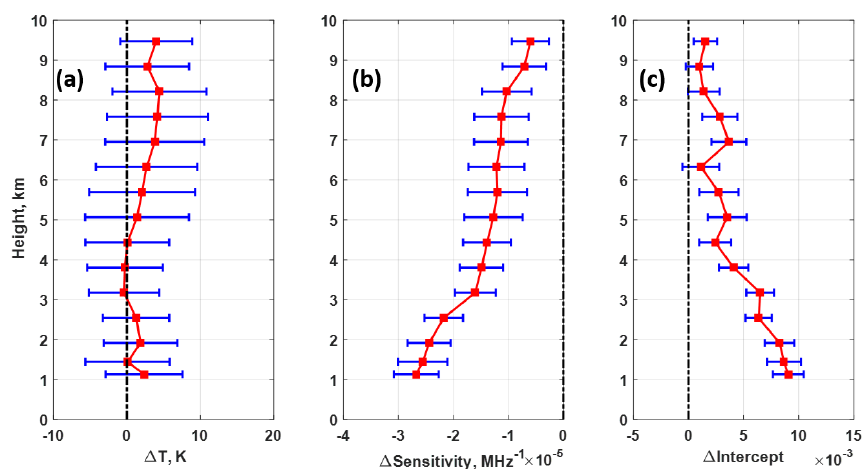
Figure 11. (a) Difference in temperature between dropsondes used in SRRC and the one during A2D instrument response calibration, and the difference in (b) sensitivity and (c) intercept derived from A2D SRRC and MRRC. The red square and the blue bar represent the mean bias and standard deviation at each height, respectively.